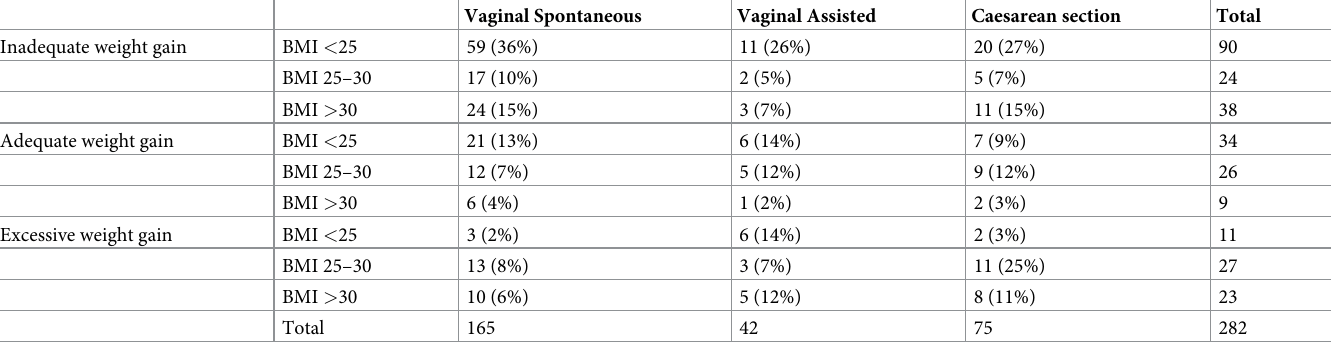
Table 3. Birth outcomes stratified according to adequacy of GWG and BMI